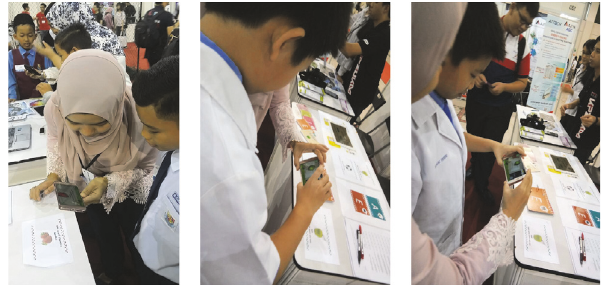
Figure 5: Experiment and